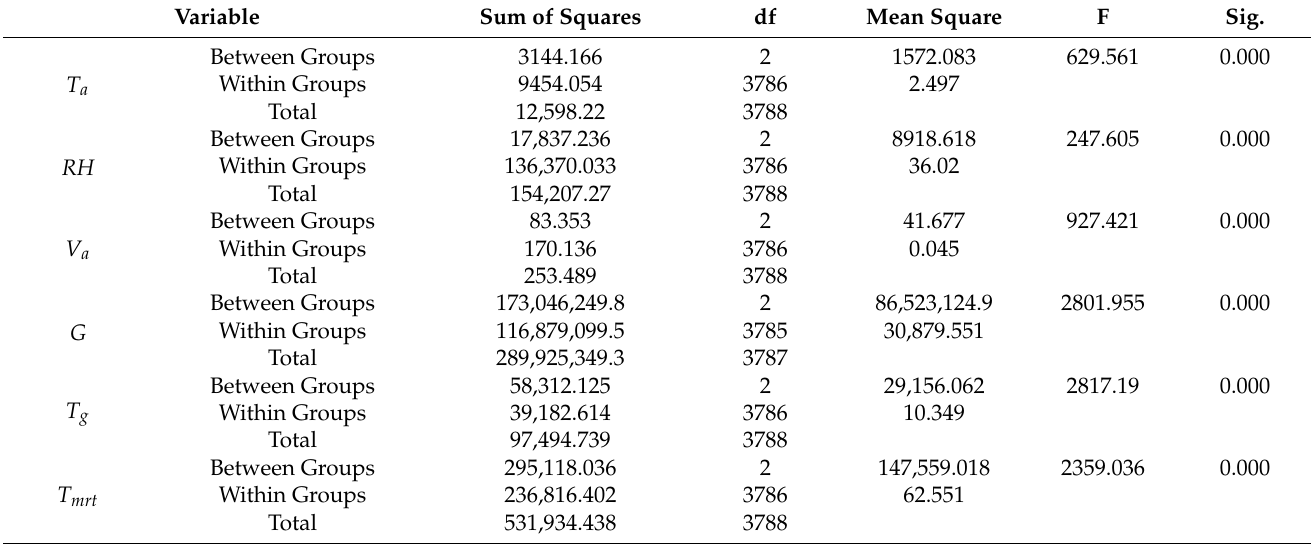
Table 6. Analysis of variance (ANOVA) for meteorological